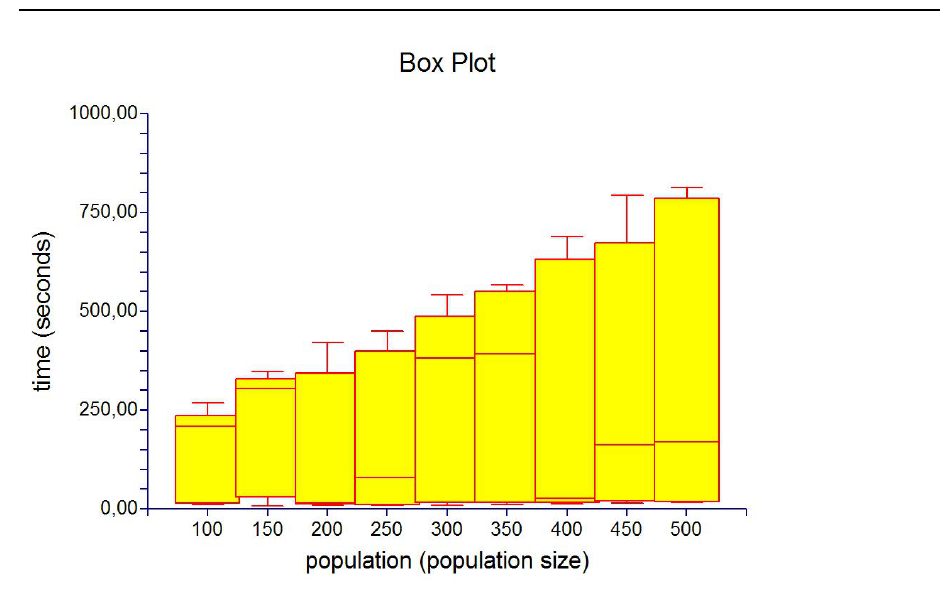
Figure 12. Exp. no. 3—Box Plot.